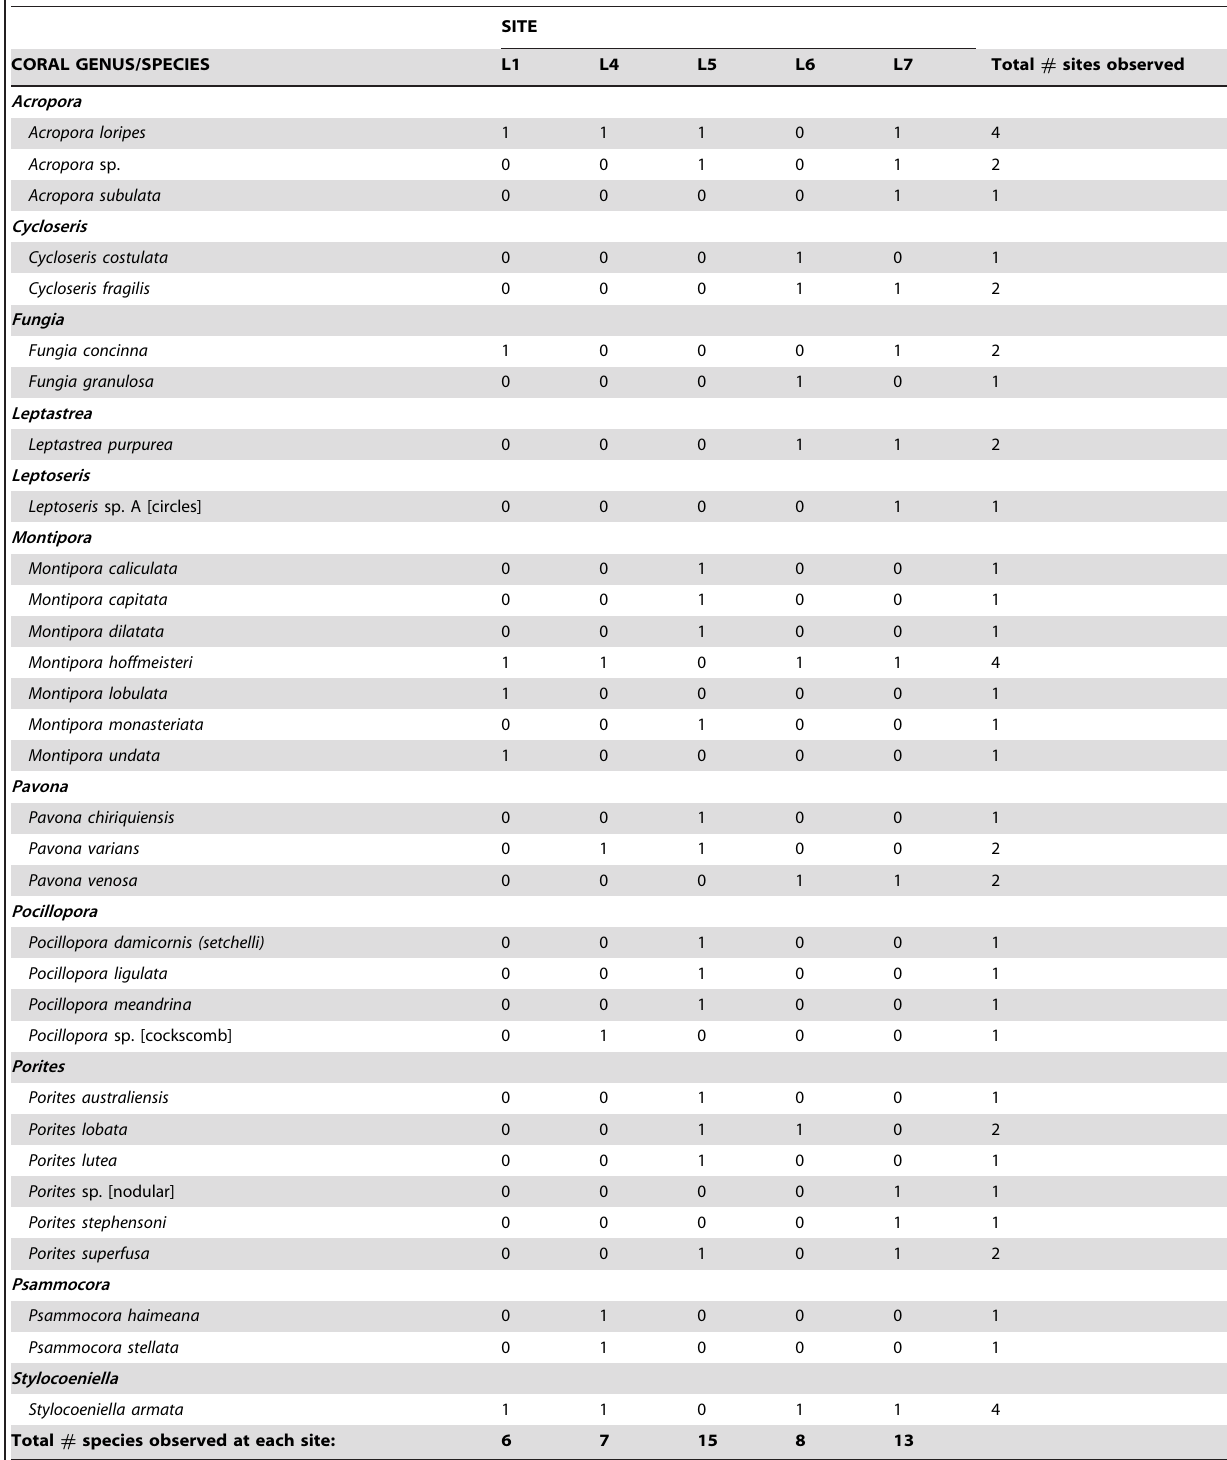
Table 1. List of 32 stony coral species observed at 5 sites surveyed in Millennium